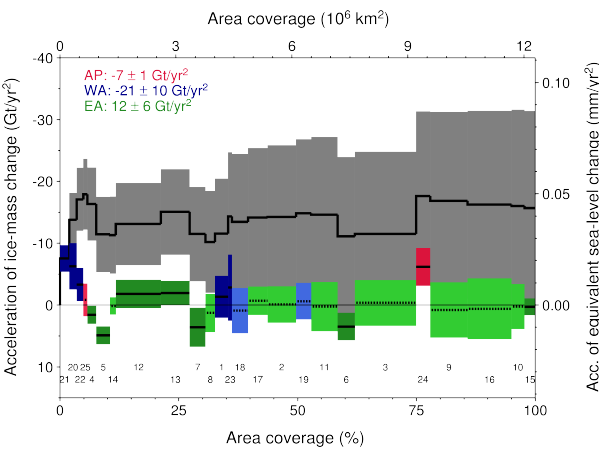
Fig. 7. Same as Fig. 6 but for the acceleration of basin-scale ice- mass change (Gtyr − 2 )